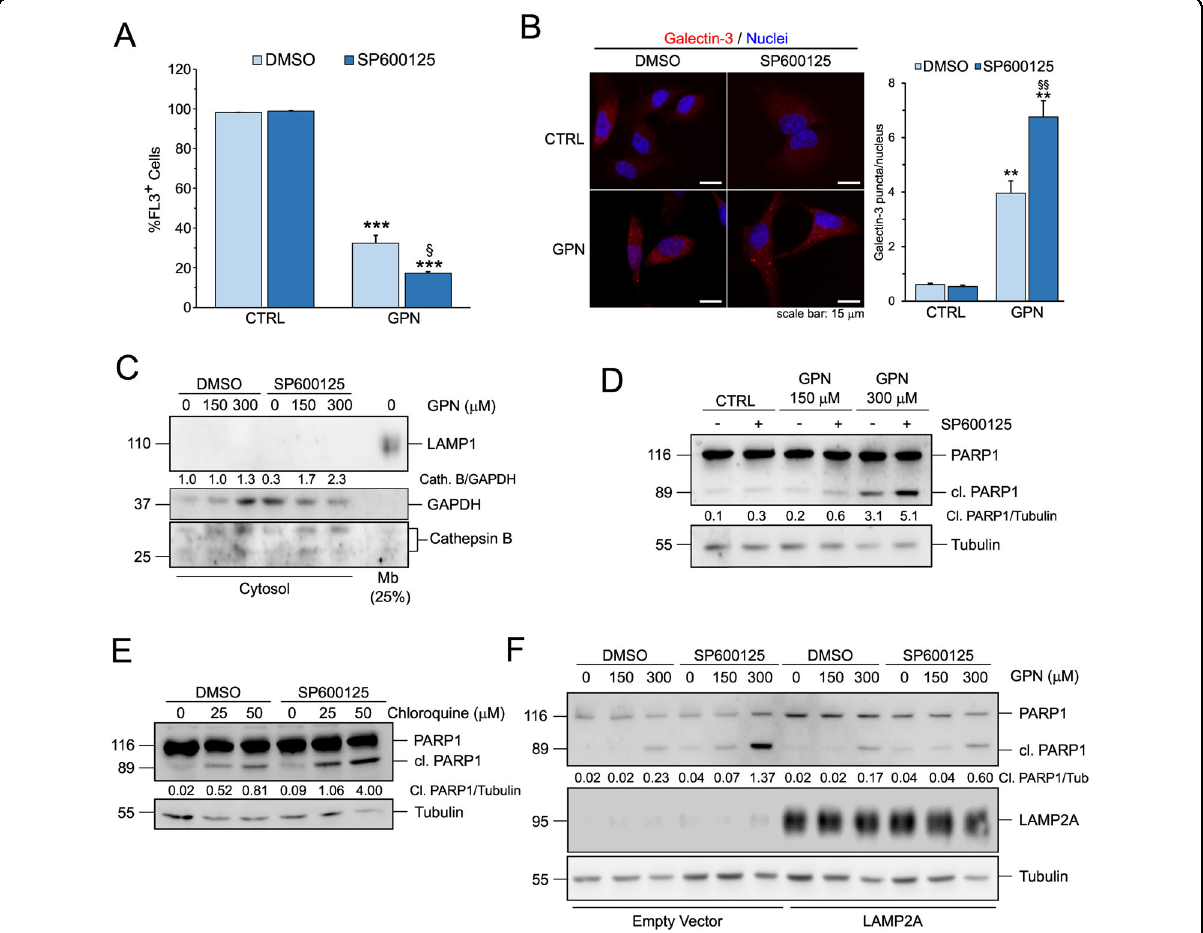
Fig. 2 JNK inhibition impacts on lysosomal homeostasis. A Cyto fl uorometric analysis of intracellular acidi fi cation using acridine orange in Hep3B pre-treated for 6 h with 10 μ M SP600125 and then treated with 300 μ M GPN for an additional 2 h. Data are expressed as mean ± SEM of n = 3 independent experiments. *** p < 0.001 vs. CTRL; § p < 0.05 vs. DMSO. B Fluorescence microscopy analysis of galectin-3 puncta in Hep3B